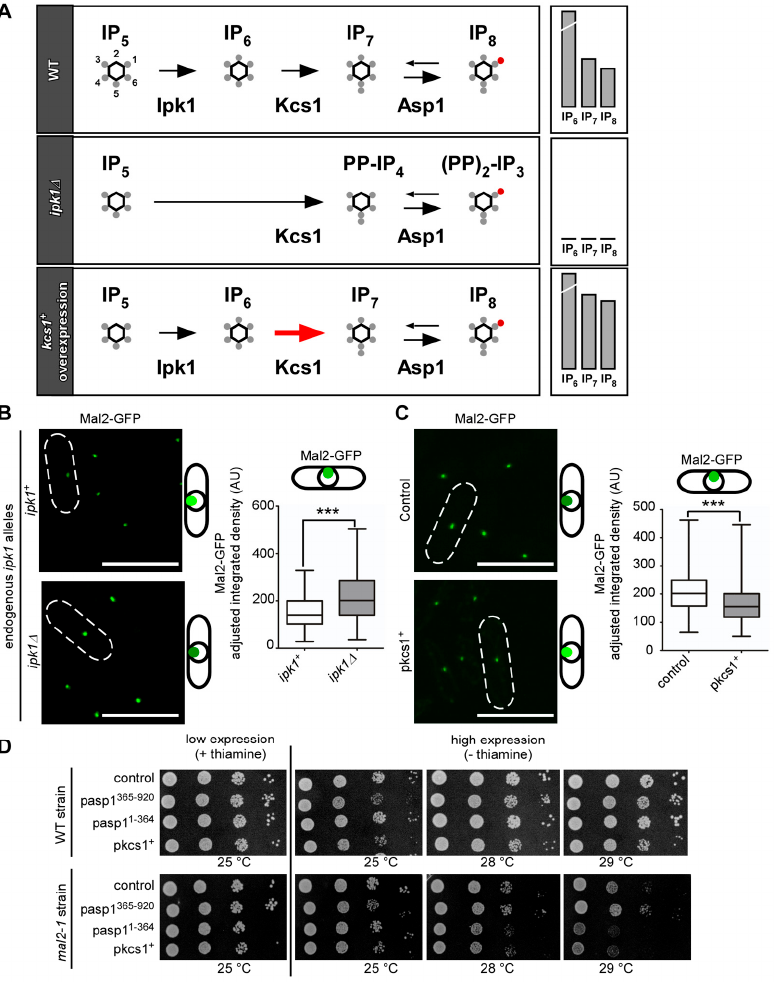
Figure 6. Alterations of the IP 8 synthesis pathway reveal that kinetochore targeting depends on IP 8 and not IP 7 levels. ( A ) Schematic representation of part of the wild-type IP/IPP pathway from IP 5 to IP 8 , and the changes in IP 7 and IP 8 in a S. pombe ipk1 ∆ strain [96] and a wild-type S. cerevisiae strain overexpressing KCS1 (red arrow) based on [99]. ( B ) Left: Live-cell images of ipk1 + and ipk1 ∆ strains endogenously expressing mal2 + -gfp . Cells were grown at 30 °C. Scale bars, 10 µm. Right: Quantification of Mal2-GFP kinetochore fluorescence signals in each strain. Mean and SD: ipk1 + = 152.3 AU ± 65.86; ipk1 ∆ = 213.1 AU ± 93.54. Number of kinetochore signals that were counted; ipk1 + = 243; ipk1 ∆ = 183. ***, p < 0.0001; Mann–Whitney U-Test. N = 2. ( C ) Left: Live-cell images of a wild-type strain that were transformed with either control plasmid or a plasmid harboring kcs1 + overexpressed via the nmt41 promoter. The cells were grown at 30 ◦ C. Scale bars, 10 µ m. Right: Quantification of Mal2-GFP fluorescence signals in each condition. Mean and SD: control plasmid = 205.5 AU ± 65.8; pkcs1 + = 164.6 AU ± 63.39. Number of kinetochore signals that were counted; control n = 594; pkcs1 + n = 609; ***, p < 0.0001; Mann–Whitney U-Test. N = 2. ( D ) Serial dilution patch test (10 4 –10 1 cells) of wild-type and mal2-1 strains that were transformed with the indicated plasmids and grown at 25 to 29 ◦ C and with/without thiamine for 4–8 days. One of n = 2–3 sets